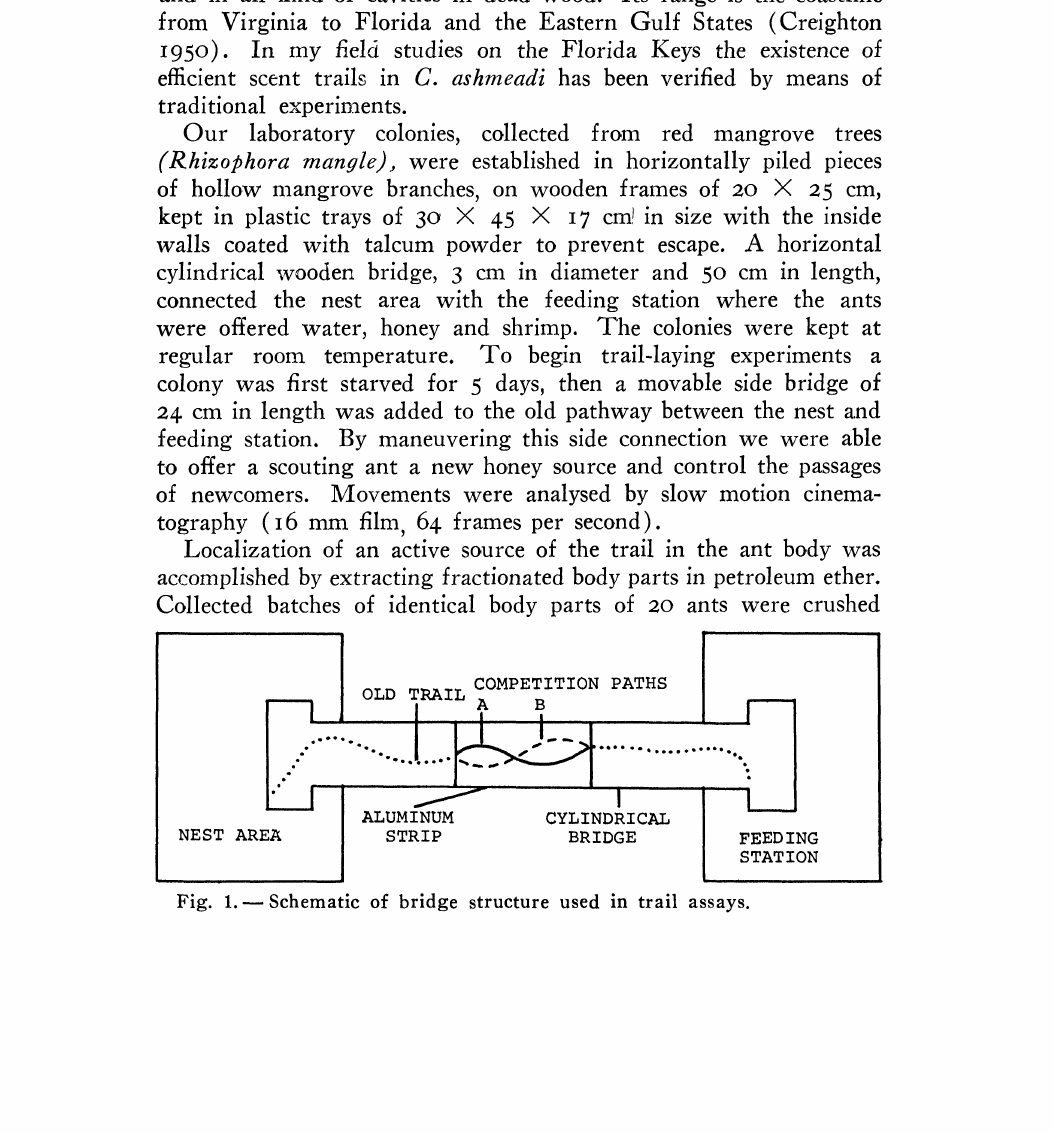
Fig. 1.-- Schematic of bridge structure used in trail